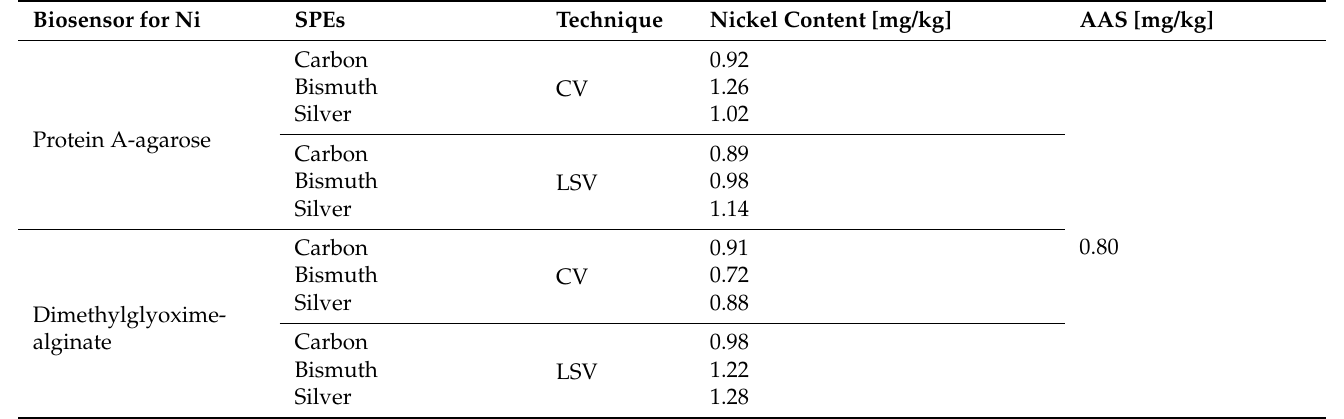
Table 3. Nickel content in zucchini ( Cucurbita pepo